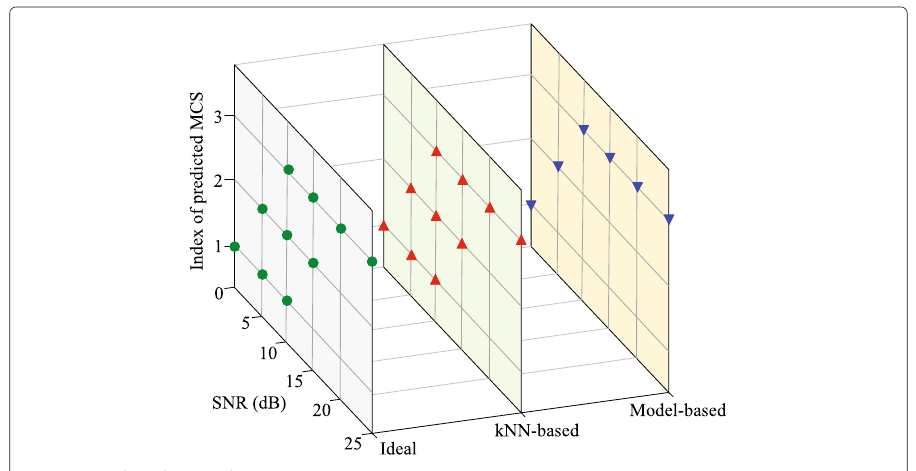
Fig. 11 Predicted optimal MCS vs